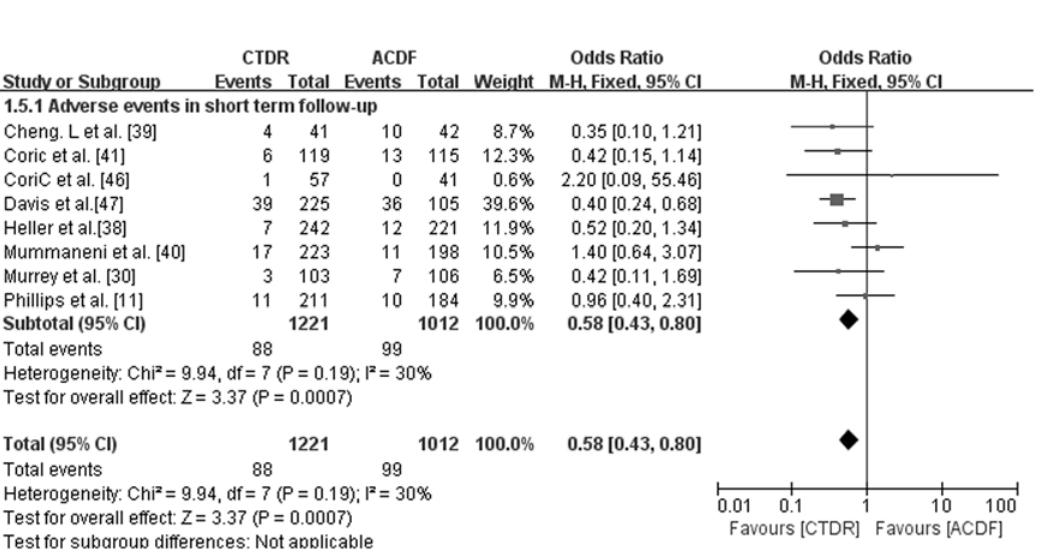
Fig 6. Comparison of Adverse events between the cervical total disc replacement (CTDR, experimental) group and the fusion (ACDF, control) group in short-term follow-up. MH = Mantel-Haenszel, CI = confidence interval, and df = degrees of